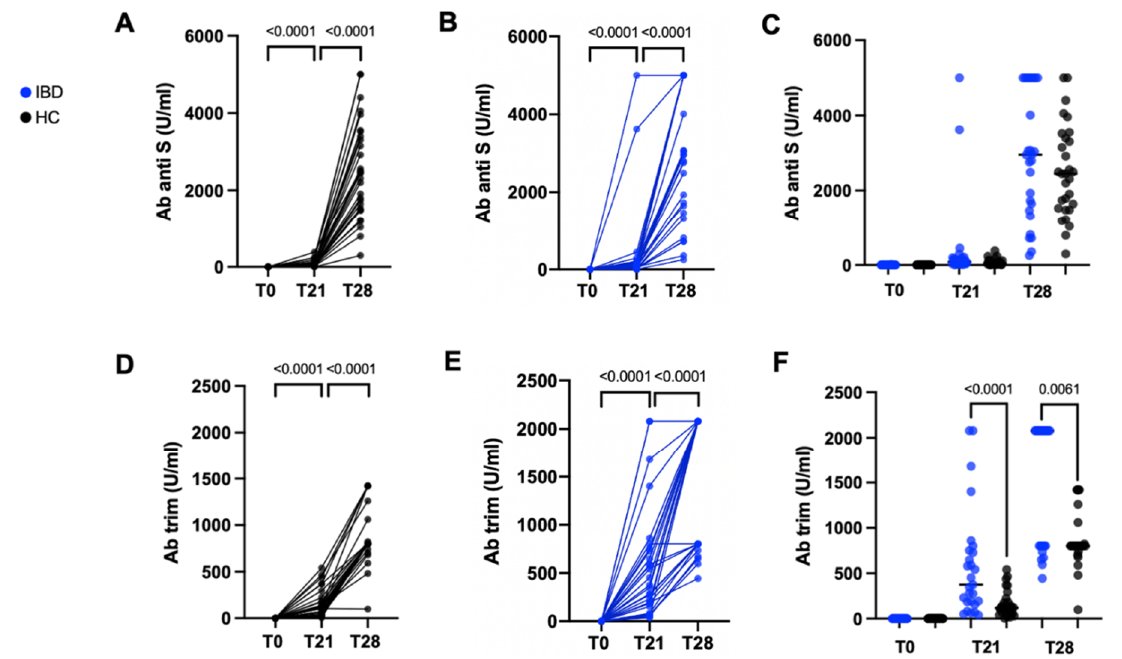
Figure 1. Longitudinal analysis of anti-S ab ( A , B ) and trim ab ( D , E ), respectively, in HC and pIBD. Paired non-parametric test (Wilcoxon Signed Rank Test) was performed to define longitudinal Ab increase ( A , B , D , E ). Differences between HC and IBD were calculated for anti-S Ab ( C ) and trim Ab ( F ) at T0, T21, and T28. Unpaired non-parametric test (Mann–Whitney test) was used for comparison.